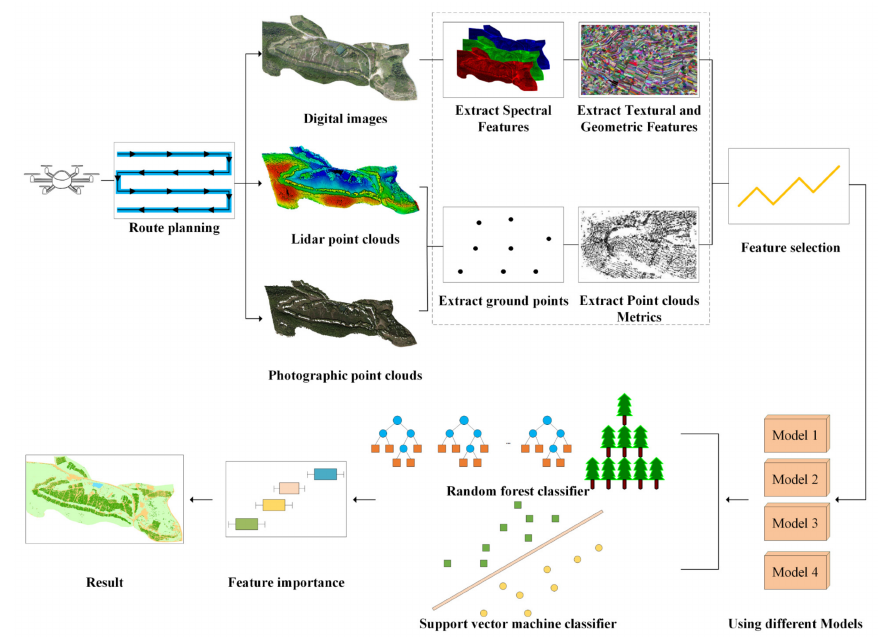
Figure 6. A schematic graph of the tea plantation identification process with four different